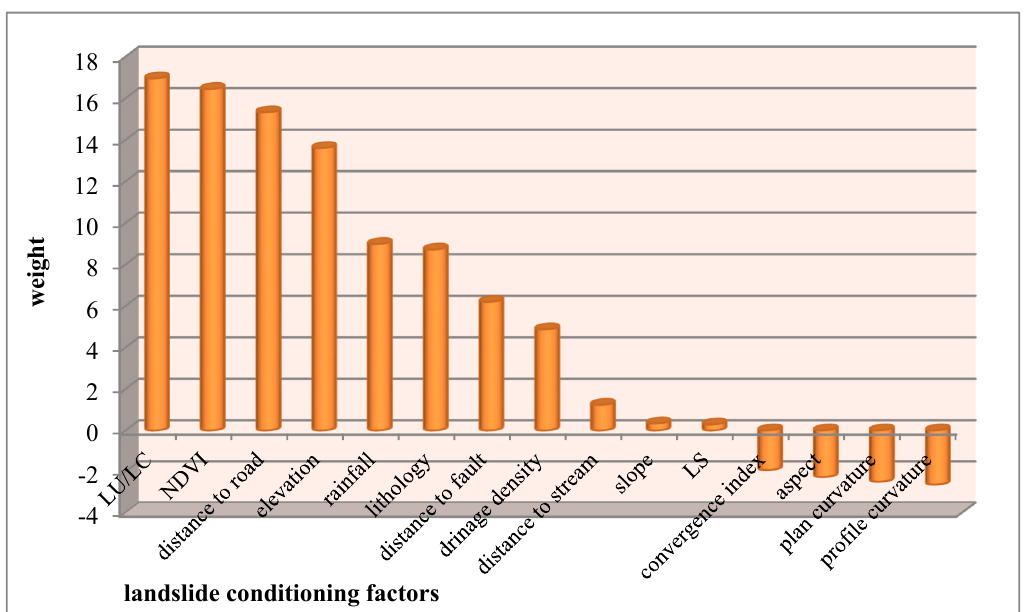
Figure 6. Determining the importance of LCFs using RF.